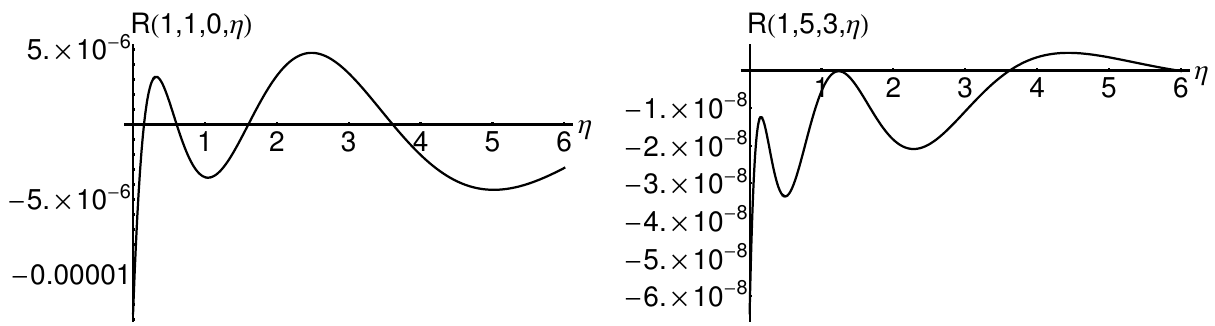
Figure 11: The residual R (1, 1, 0, η ) for Eq. (47) obtained by OAFM